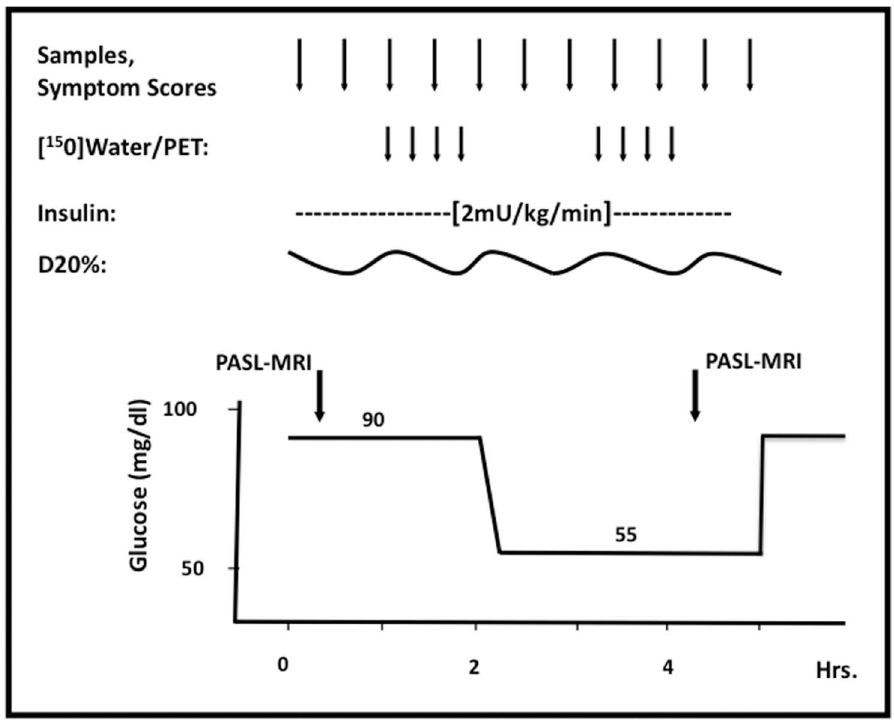
Figure 1. Schematic diagram of experimental protocol. Counterregulatory hormone levels, hypoglycemic symptom scores and rCBF measurements were obtained during the hyperinsulinemic euglycemic – hypoglycemic clamp. rCBF measurements were obtained using PASL-MRI and [ 15 O]water PET for healthy individuals ( n =9).